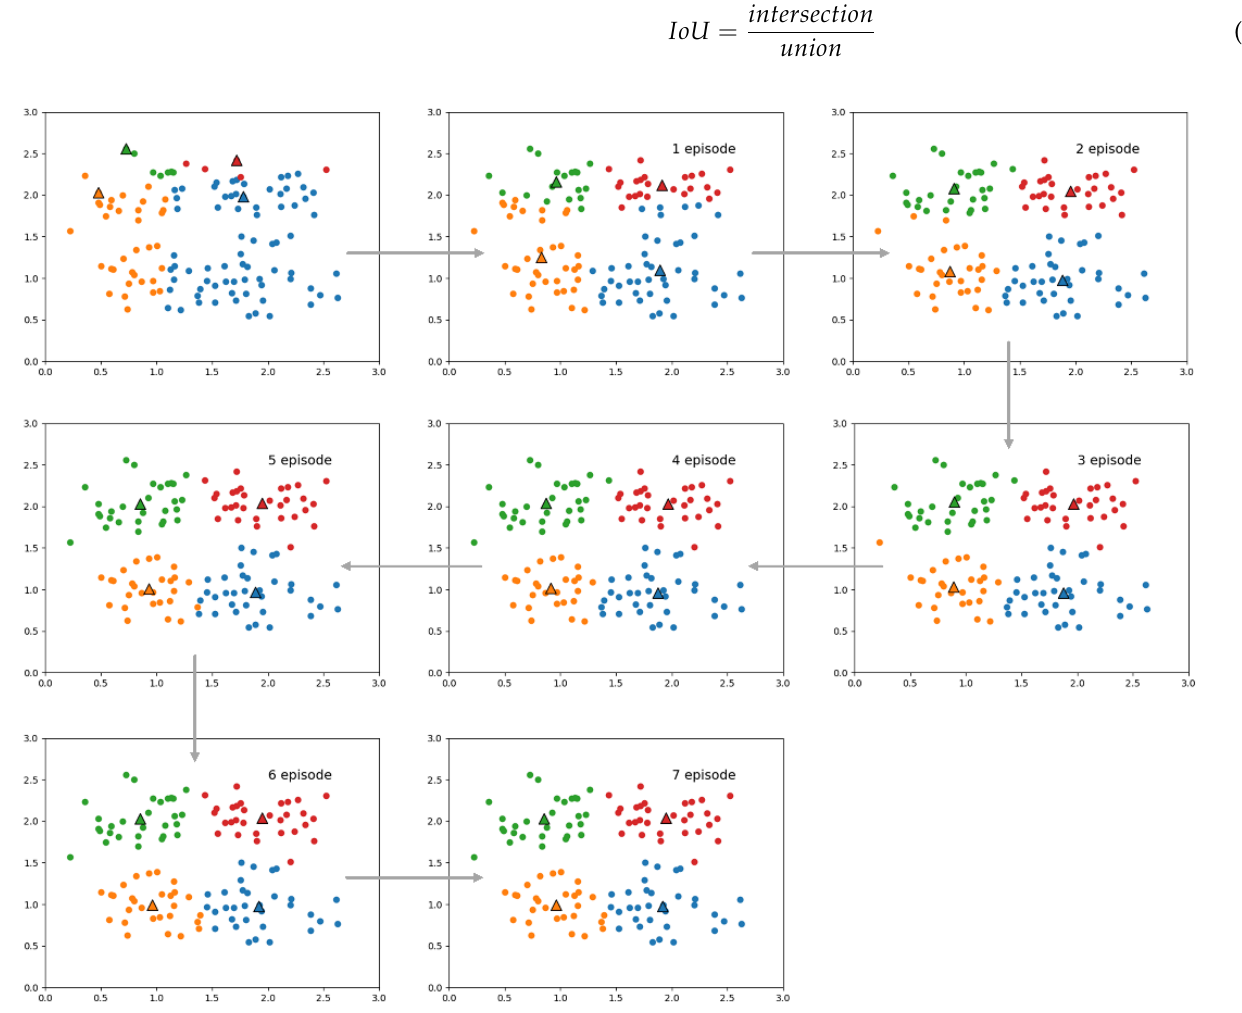
Figure 6. K-means algorithm clustering schematic.